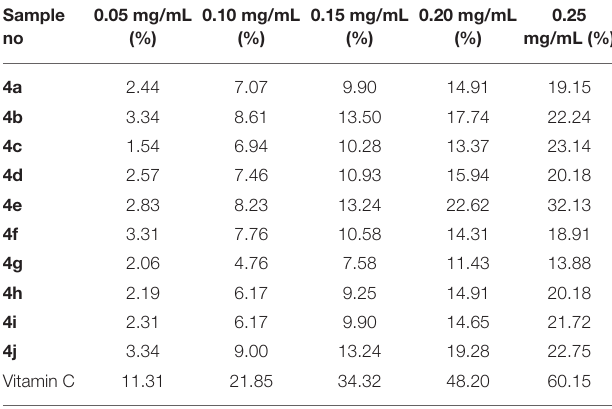
TABLE 3 | General sensitivity of compounds against microorganism.